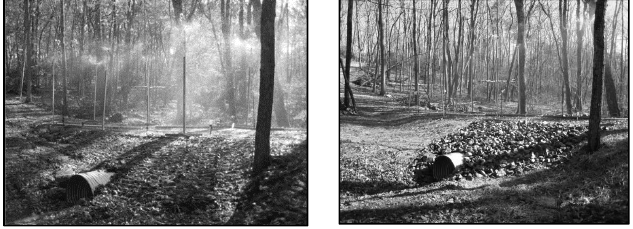
Figure 2. Left : Culvert after installation and during BMP − rainfall simulation; Right : Culvert prior to BMP+ rainfall simulation with rocked running surface and fill slopes and seed and mulch on bare soil.